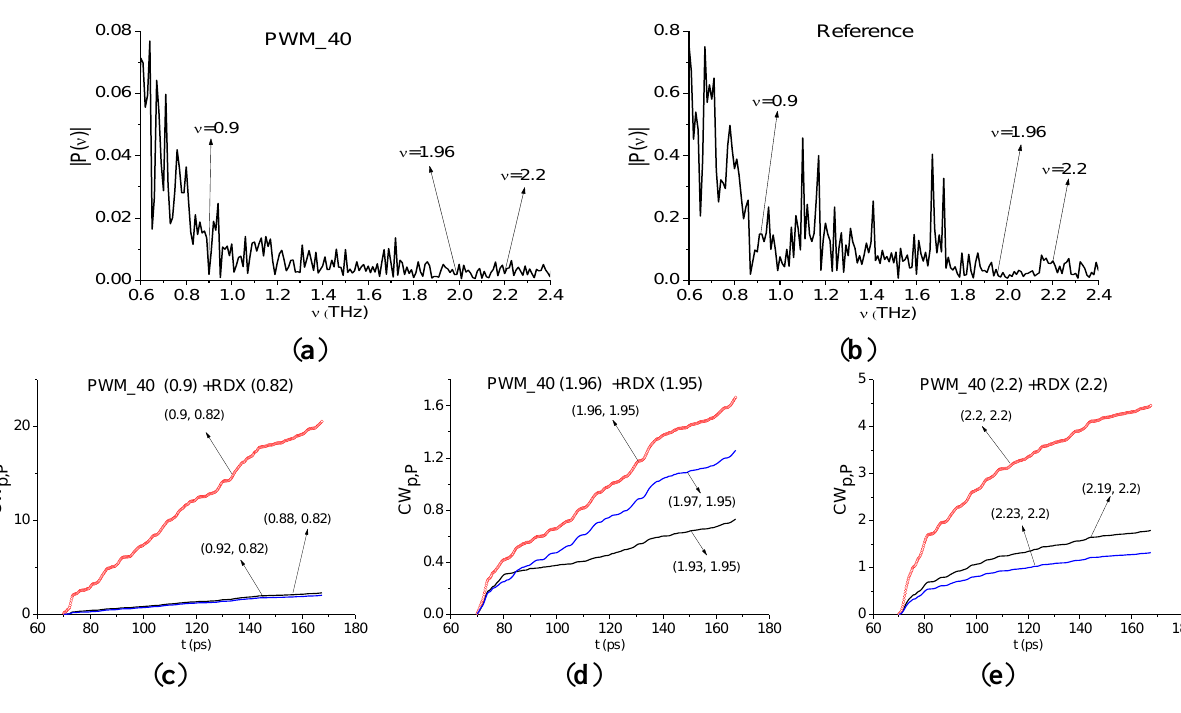
Figure 18. Fourier spectra of the PWM_40 signal ( a ) and Reference ( b ), calculated in the time interval t = [70, 170] ps, integral characteristics CW p , P ( t n ) detecting the frequencies ν = 0.9 THz ( c ); 1.96 THz ( d ); 2.17 THz ( e